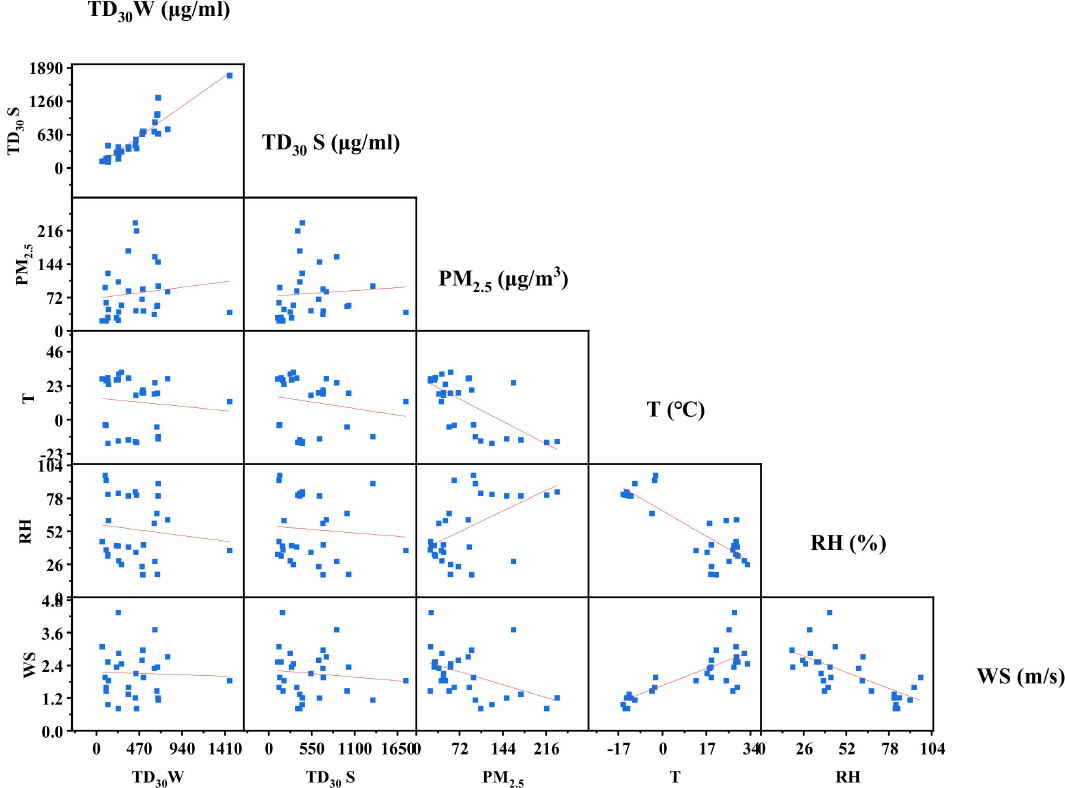
Figure 5. Correlations between the TD 30 values of whole samples and corresponding water-soluble fractions and the examined environmental